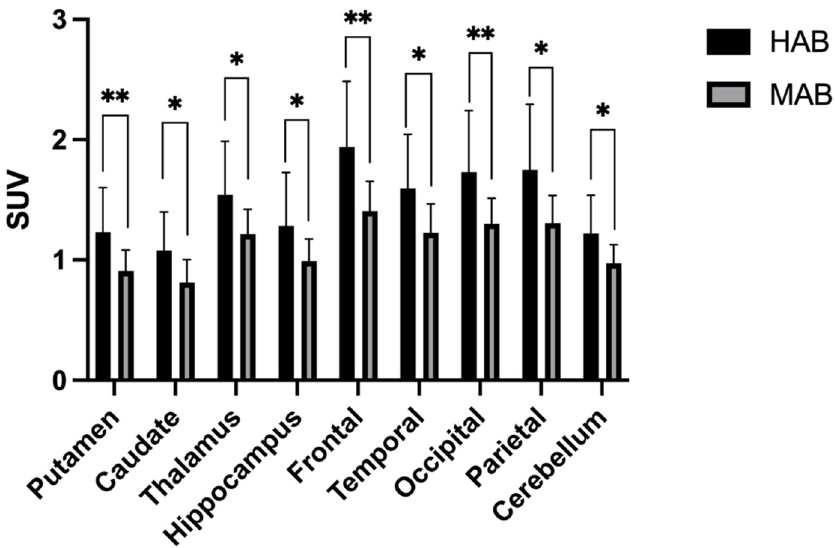
Figure 3. The box plot of the SUV measured for target brain regions for high- and mixed-affinity binders in the nonblood-sampling cohort. * denotes significant differences under two-sample t -test ( p < 0.05), while ** denotes p < 0.01. All nine target regions showed significant differences between the HAB and MAB subjects. SUV is 31 ± 3% higher in HAB than in MAB.